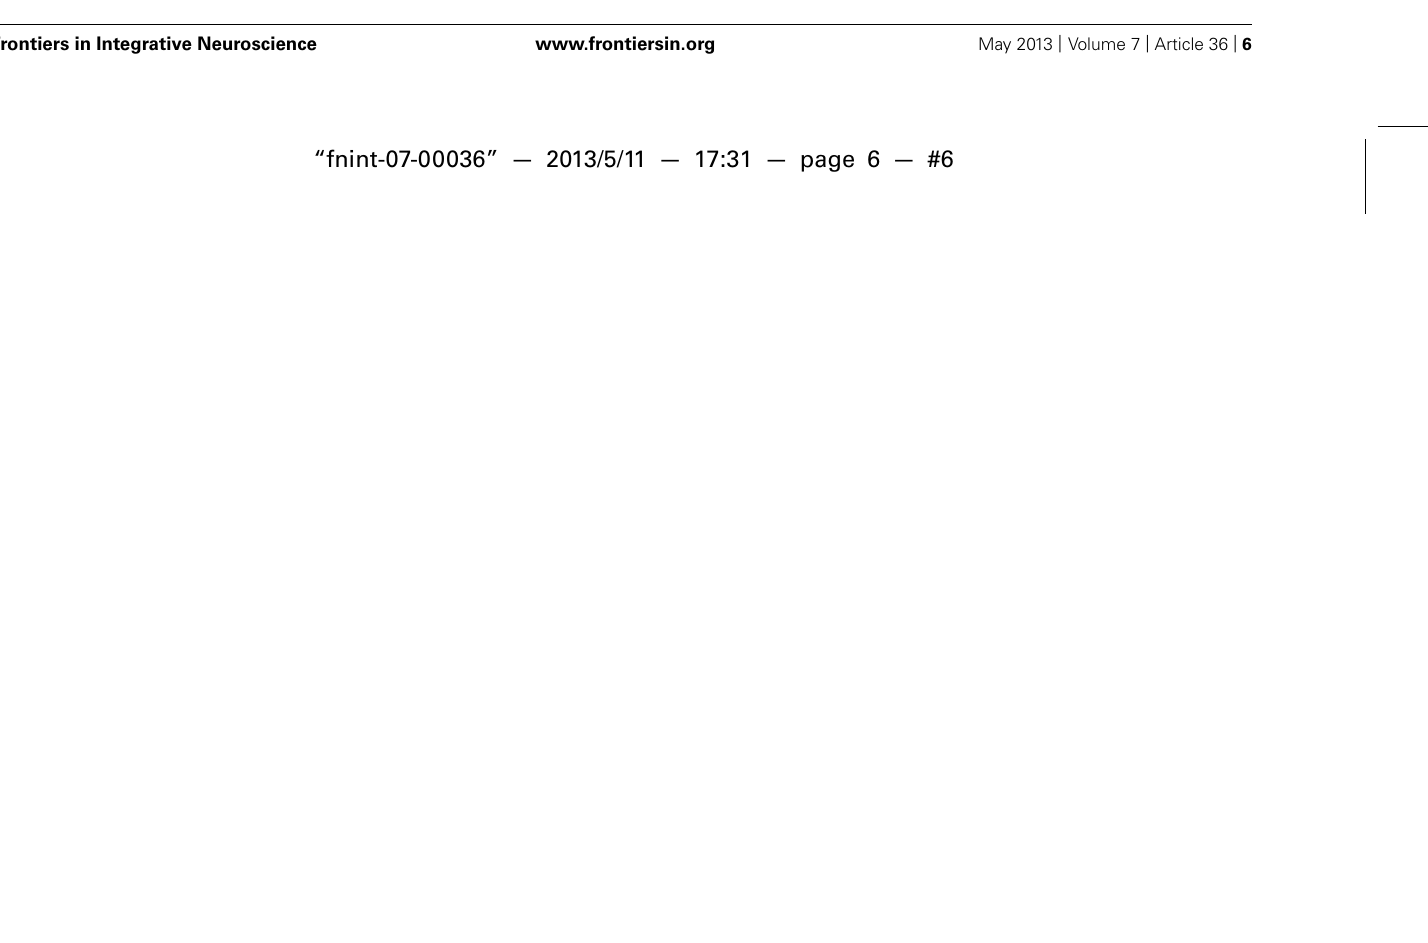
FIGURE 4 |Activity of the tonic excitatory and suppressive neurons of the PPTN for the saccade task. (A–C) The activity of each PPTN neuron is presented as a row of pixels for the task with ( A , N = 507) and without ( C , N = 185) FP presentation. From left to right, the data are aligned to the time of FP/FT onset, FT onset, ST onset, and reward delivery, respectively. The data were plotted separately for neurons that showed an increase in tonic activity (top), no significant modulation (middle), and a decrease in tonic activity (bottom).The neurons have been sorted in the order of their initiation of changes in tonic firing.The color of each pixel indicates the ROC value based on the comparison of the firing rate between a